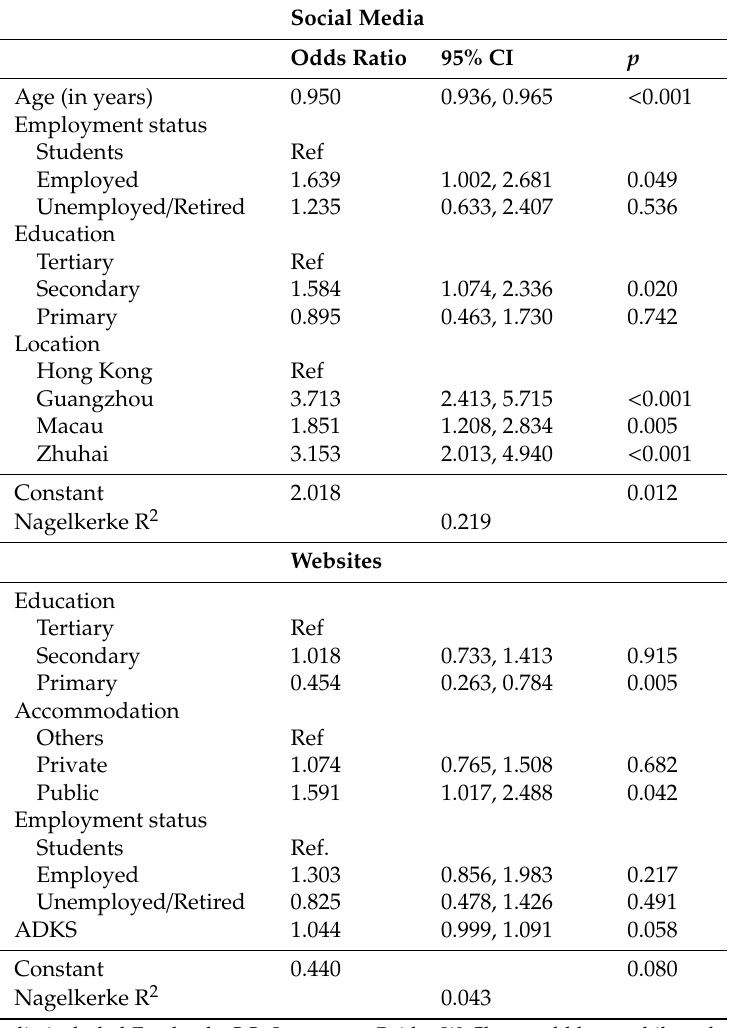
Figure 3. Preferences in mass media for receiving dementia information . Table 3. Preferred digital media for receiving dementia information .